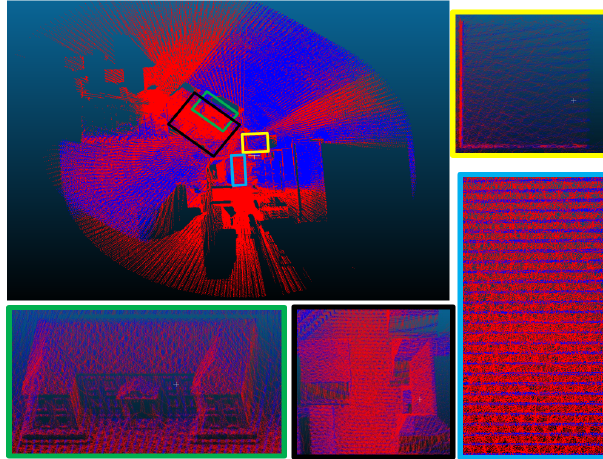
Figure 10. Comparison between the two rendered maps: fixed (bleu)and rotating payload (red). Images surrounded by colors show zooming parts shown by squares of the same color on the main figure